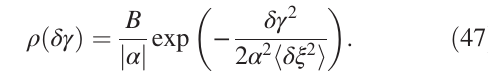
= ϵ through 85 accel- N N 0 . The colormap/ N 0 = ϵ N N 0